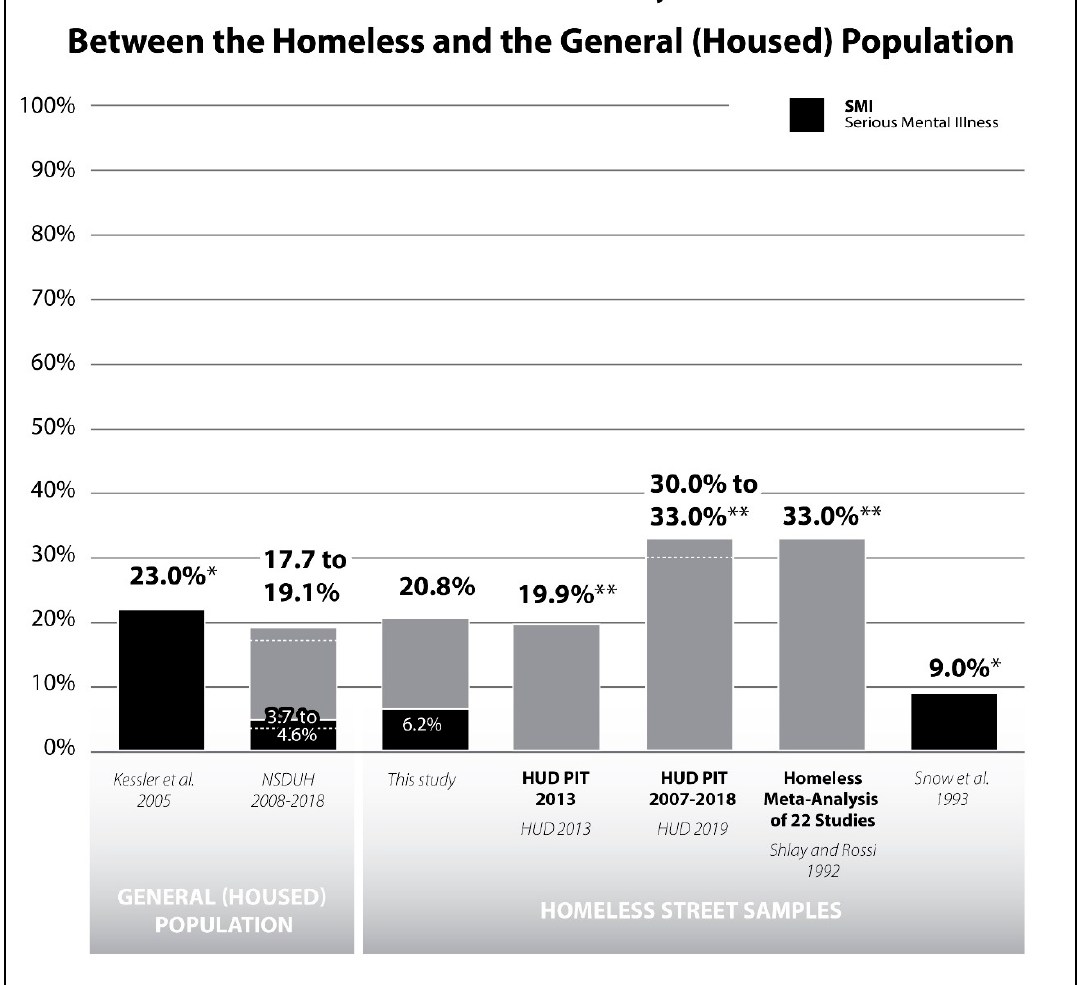
Figure 3. Comparison across studies, including HUD (2013), HUD 2007–2018 (2019), Kessler et al. (2005), NSDUH (2018), Snow and Anderson (1993), and Shlay and Rossi’s meta-analysis (1992). Studies that sample only sheltered or otherwise institutionalized homeless are omitted. * Studied only SMI; ** Studied any mental illness (did not specify SMI).